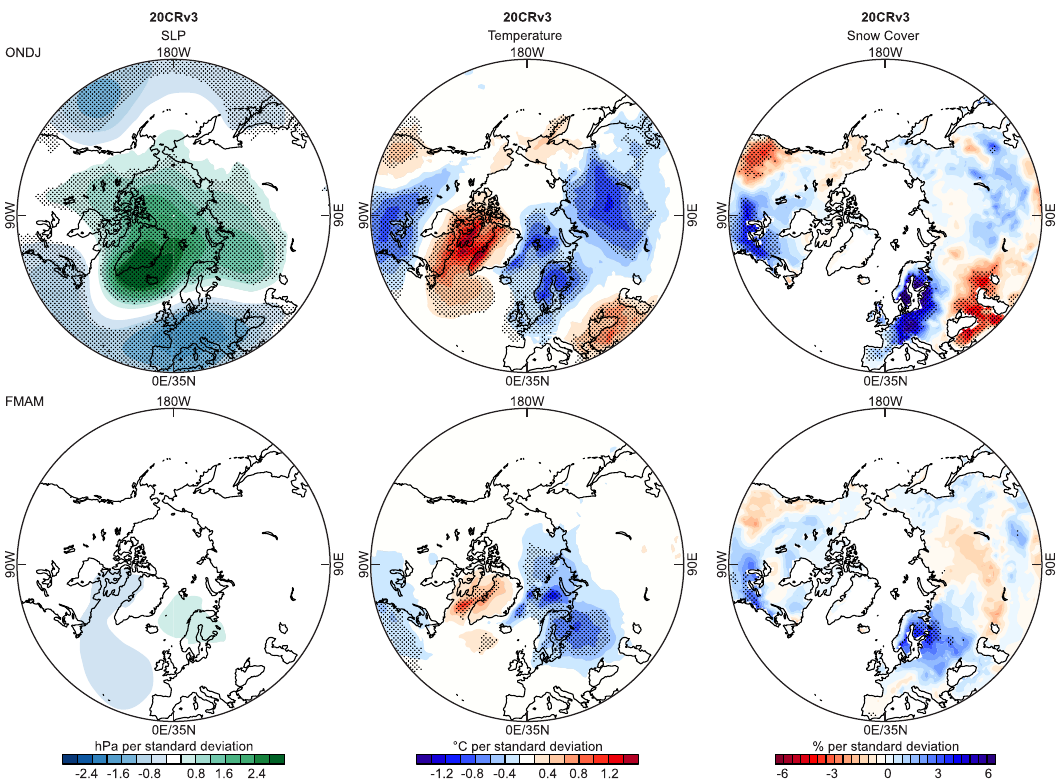
Fig. 4 Seasonal persistence. Standardised regression coef fi cients of detrended SLP, temperature, and snow cover in Oct-Jan (top) and Feb-May (bottom) onto a detrended Oct-Jan SLP index (de fi ned as the difference between two points, indicated in Fig. 3) in 20CRv3, 1901 – 2000. Signi fi cant ( p < 0.05) coef fi cients are hatched.